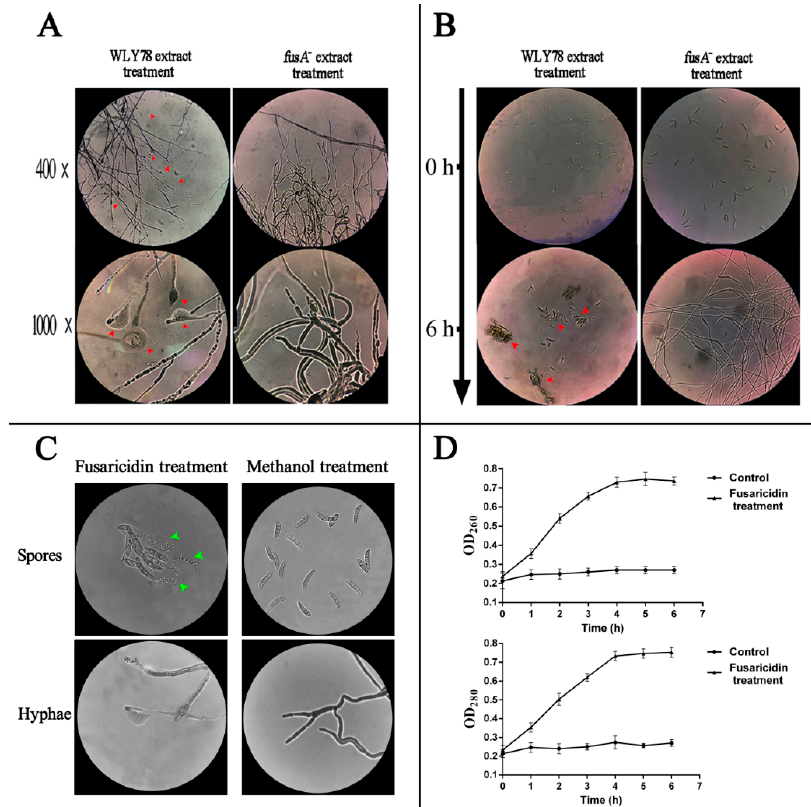
Figure 4. 400× and 1000× micrographs from an optical microscope for hyphae treated with WLY78 and the fusA ‐ mutant extracts ( A ). The 100× micrograph from an optical microscope for the germination of spores treated with WLY78 and the fusA ‐ mutant extracts for six hours ( B ). 1000× micrographs from an optical microscope for spores and hyphae treated with or without fusaricidin for two hours ( C ). Leakage levels of nucleic acid (OD 260 ) and proteins (OD 280 ) of F. oxysporum f. sp. cucumerium spore suspensions after treatment with or without purified fusaricidin were evaluated ( D ). The red arrows indicate the vesicle structures, the cytoplasm leakage, and spore aggregation. The green arrows indicate the spores bursting into pieces.